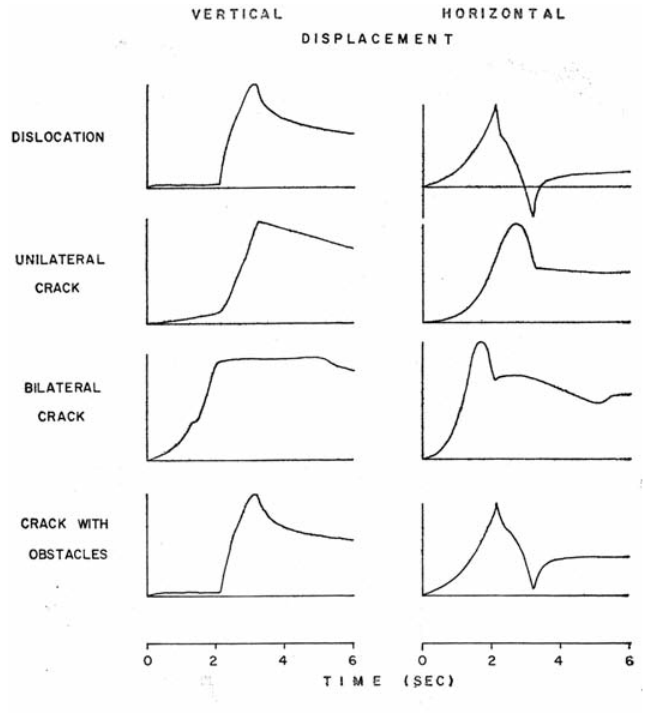
Figure 10. Synthetic surface ground motion at Pacoima Dam due to slip on the lower segment fault. The top trace corresponds to the case of uniform step-dislocation, the second from the top to the case of a single continuous unilateral crack nucleating at the bottom, the third to the case of a single continuous bilateral crack nucleating at the center of the lower fault segment, and the bottom trace to the case of multple cracks with ten equidistant unbroken barriers nucleated at the bottom. Reproduced from Bouchon [1978].